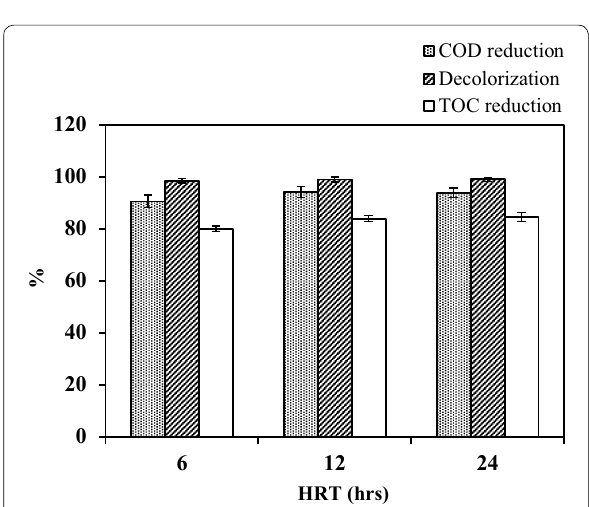
Fig. 5 Performance of designed and developed aerobic reactor in terms of decolorization, TOC, and COD